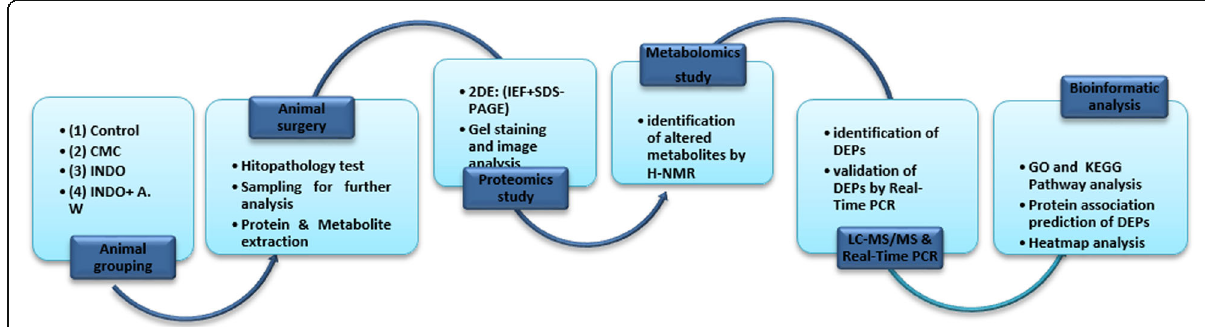
Fig. 1 The workflow of the metabolomic and proteomic analysis of the therapeutic effects of A. Wilhelmsii extract on indomethacin-induced gastric ulcer. CMC: carboxymethyl cellulose; INDO: indomethacin; A.W: Achillea Wilhelmsii ; 1 H-NMR: nuclear magnetic resonance spectrometry; 2DE: 2- dimensional electrophoresis; IEF: isoelectric focusing; SDS-PAGE: sodium dodecyl sulfate; DEPs: differential expressed proteins; GO: gene